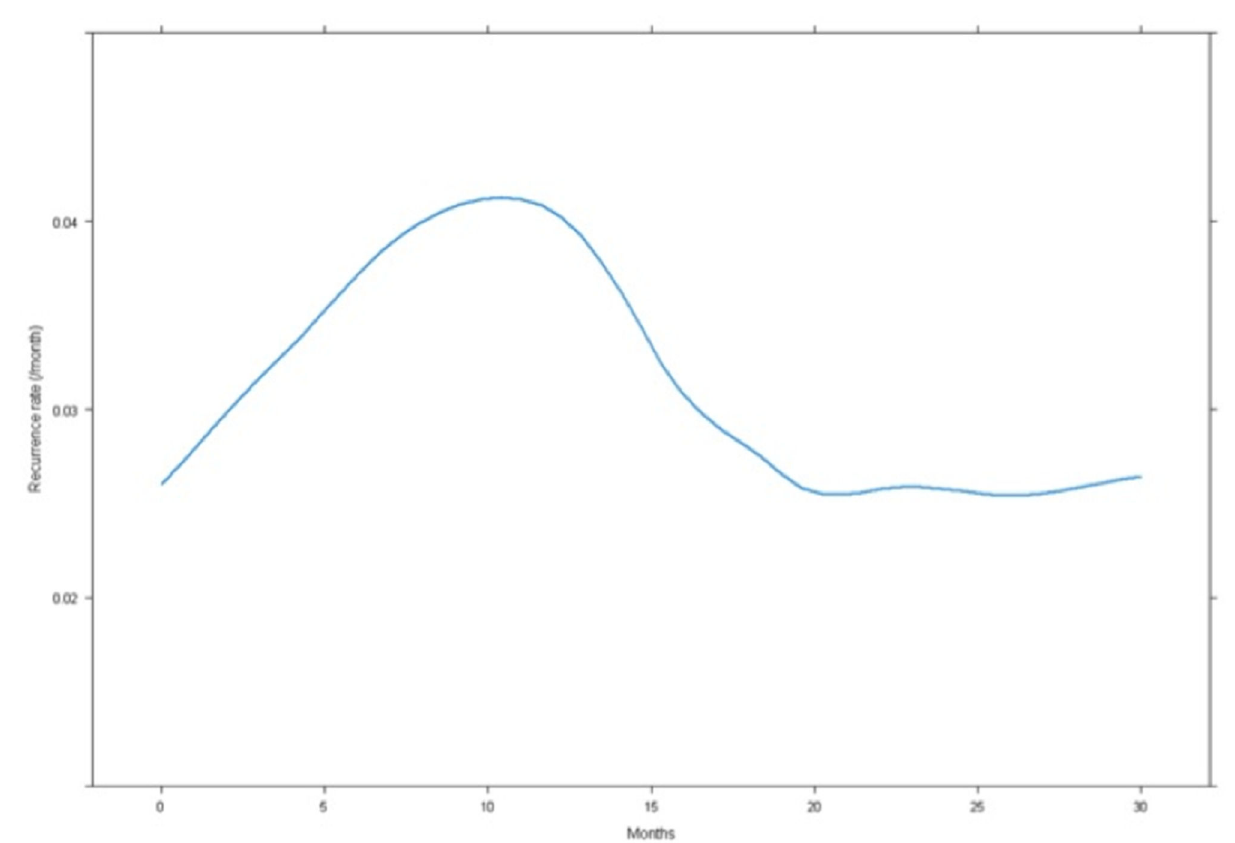
Figure 6. Distribution of the recurrence rate according to the time after resection, the higher rate of recurrence is achieved after 12